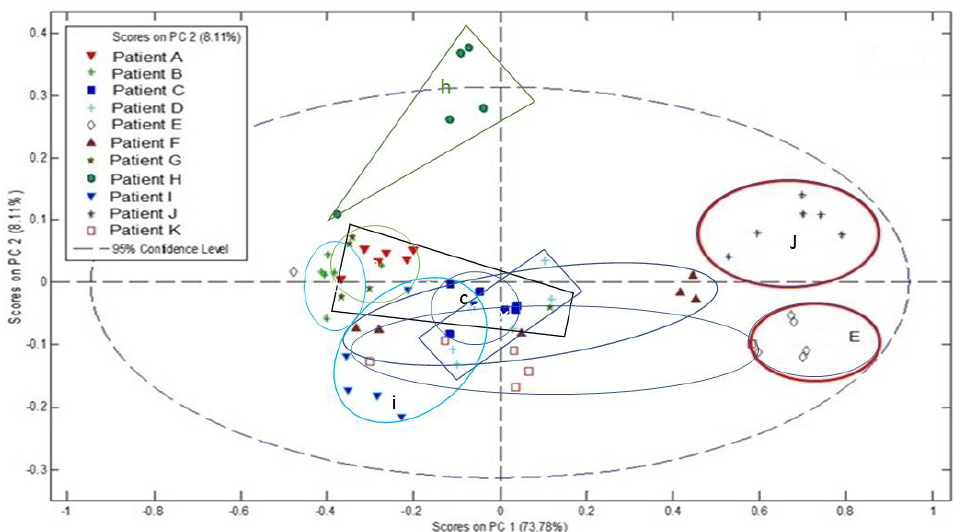
Figure 3. PCA analysis of tumour region MALDI-MSP data, from sections of FFPE human eye containing UM from 11 patients.